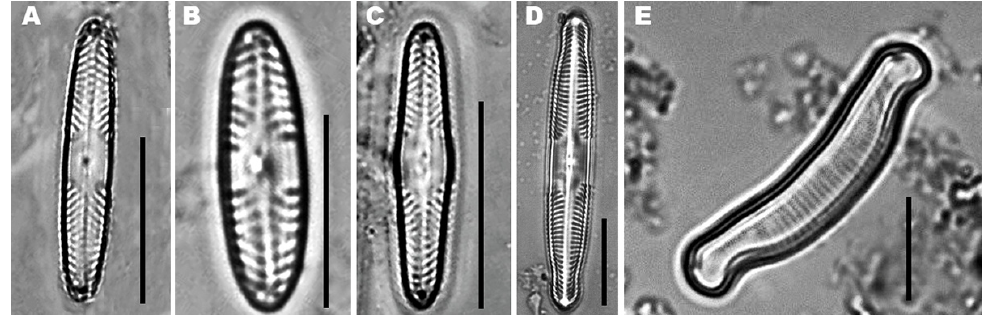
Figure 1. ( A ) Pinnularia acidophila , ( B ) Pinnularia acoricola , ( C ) Pinnularia aljustrelica , ( D ) Pinnularia subcapitata and ( E ) Eunotia exigua .